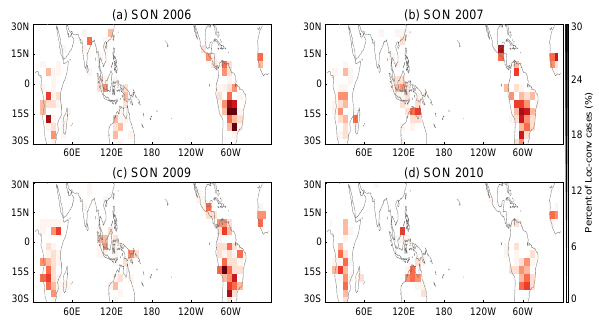
Fig. 8. Spatial distributions of the relative frequency (percentage) of the “local convection” transport pathway within each 4 ◦ latitude × 8 ◦ longitude grid box during (a) SON 2006, (b) SON 2007, (c) SON 2009 and (d) SON 2010.